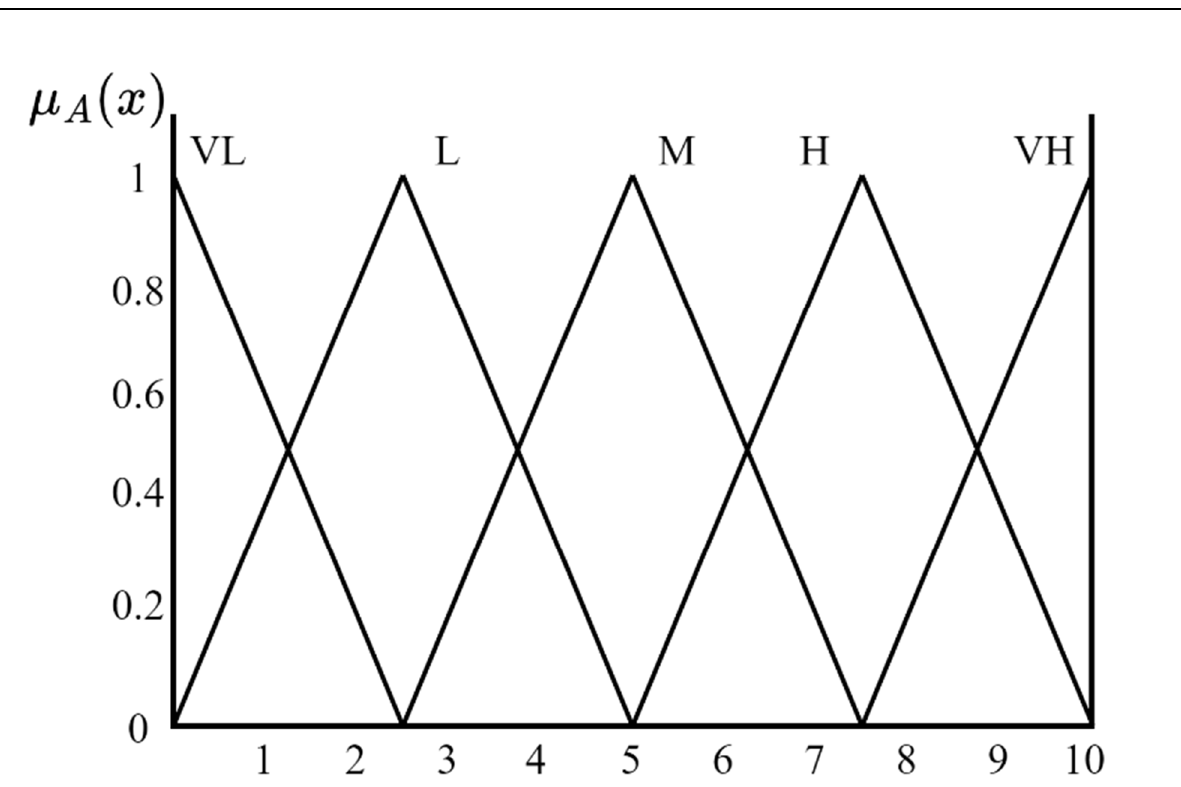
Figure 5. Membership functions of input variables.